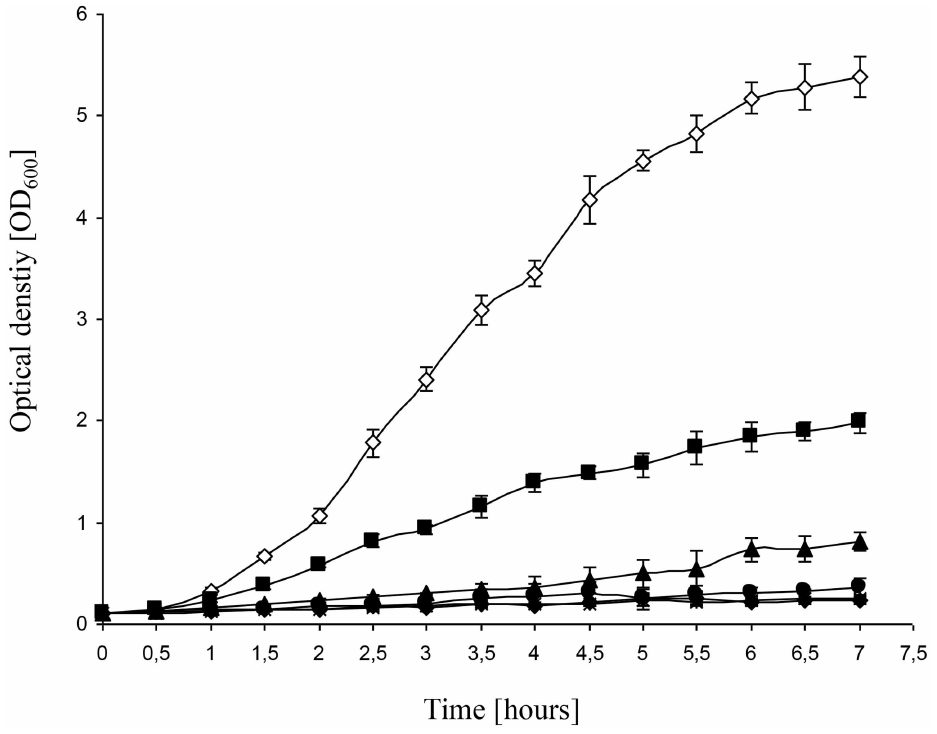
Fig 1. Inhibitory effect of Kasugamycin on the growth of E . coli MG1655. Cultures were grown in the presenceof different Kasugamycin concentrations, and the optical densitieswere determinedat the indicated times. Three biological replicates were grown, and averagevalues and standard deviations are shown. Empty diamonds: control without Kasugamycin;filled squares: 100 μ g/ml; filled triangles: 250 μ g/ml; filled circles: 500 μ g/ml; asterisks: 750 μ g/ml; filled diamonds:1000 μ g/ml.